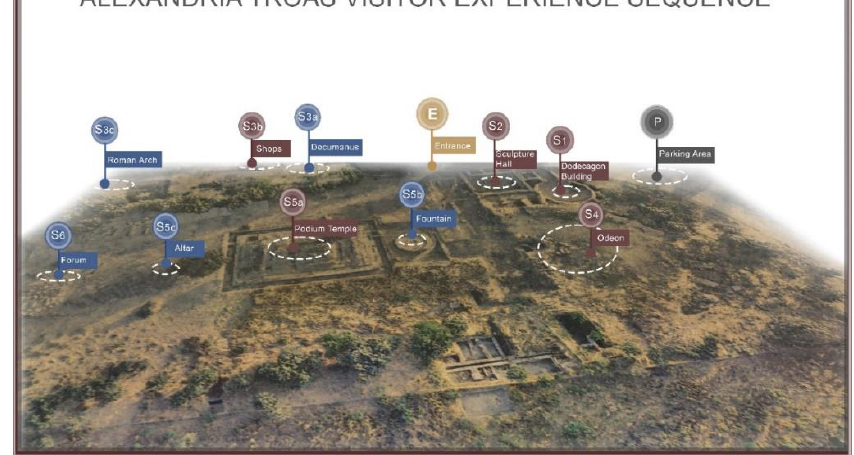
Figure 9 Visitor Experience Sequence of Scenes.